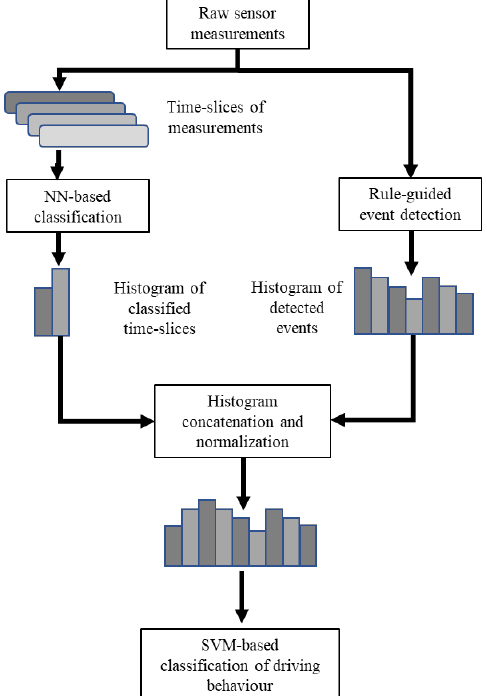
Figure 1. Summary of the main stages of the proposed approach.